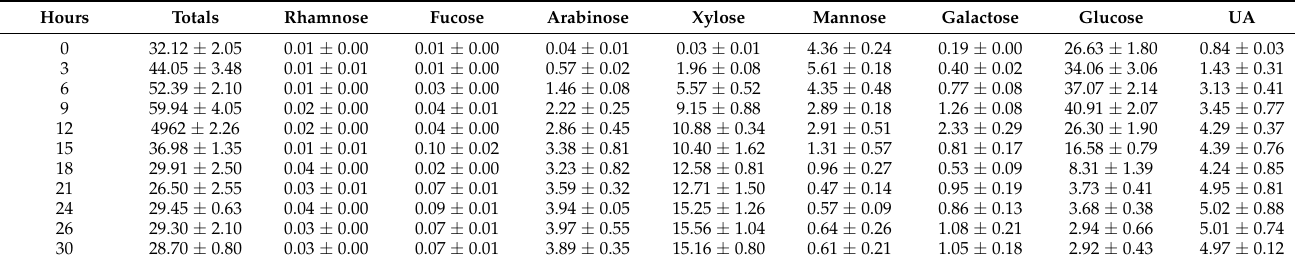
Table 3. Cell wall soluble monosaccharide composition a